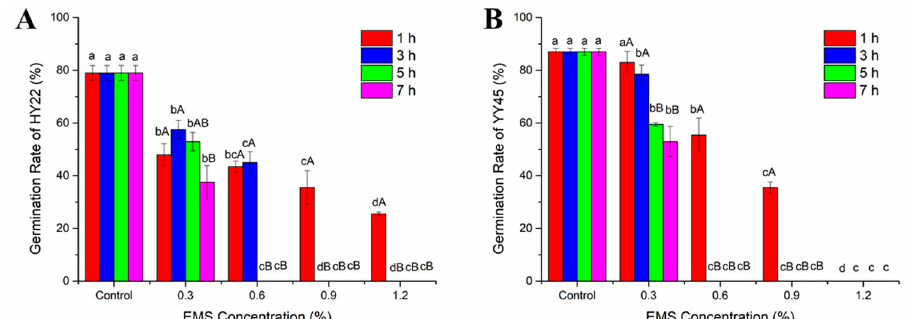
Figure 1. The germination rate of M1 generation HY22 and YY45 induced by different ethyl methyl sulfonate (EMS) treatments. ( A ) Germination rate of ‘Huayu 22’ (HY22) induced by different EMS treatment; ( B ) Germination rate of ‘Yueyou 45’ (YY45) induced by different EMS treatment. Note: Mean values within different EMS concentration followed by lower cases are significantly different at P < 0.05. Mean values within different duration followed by upper cases are significantly different at P < 0.05.